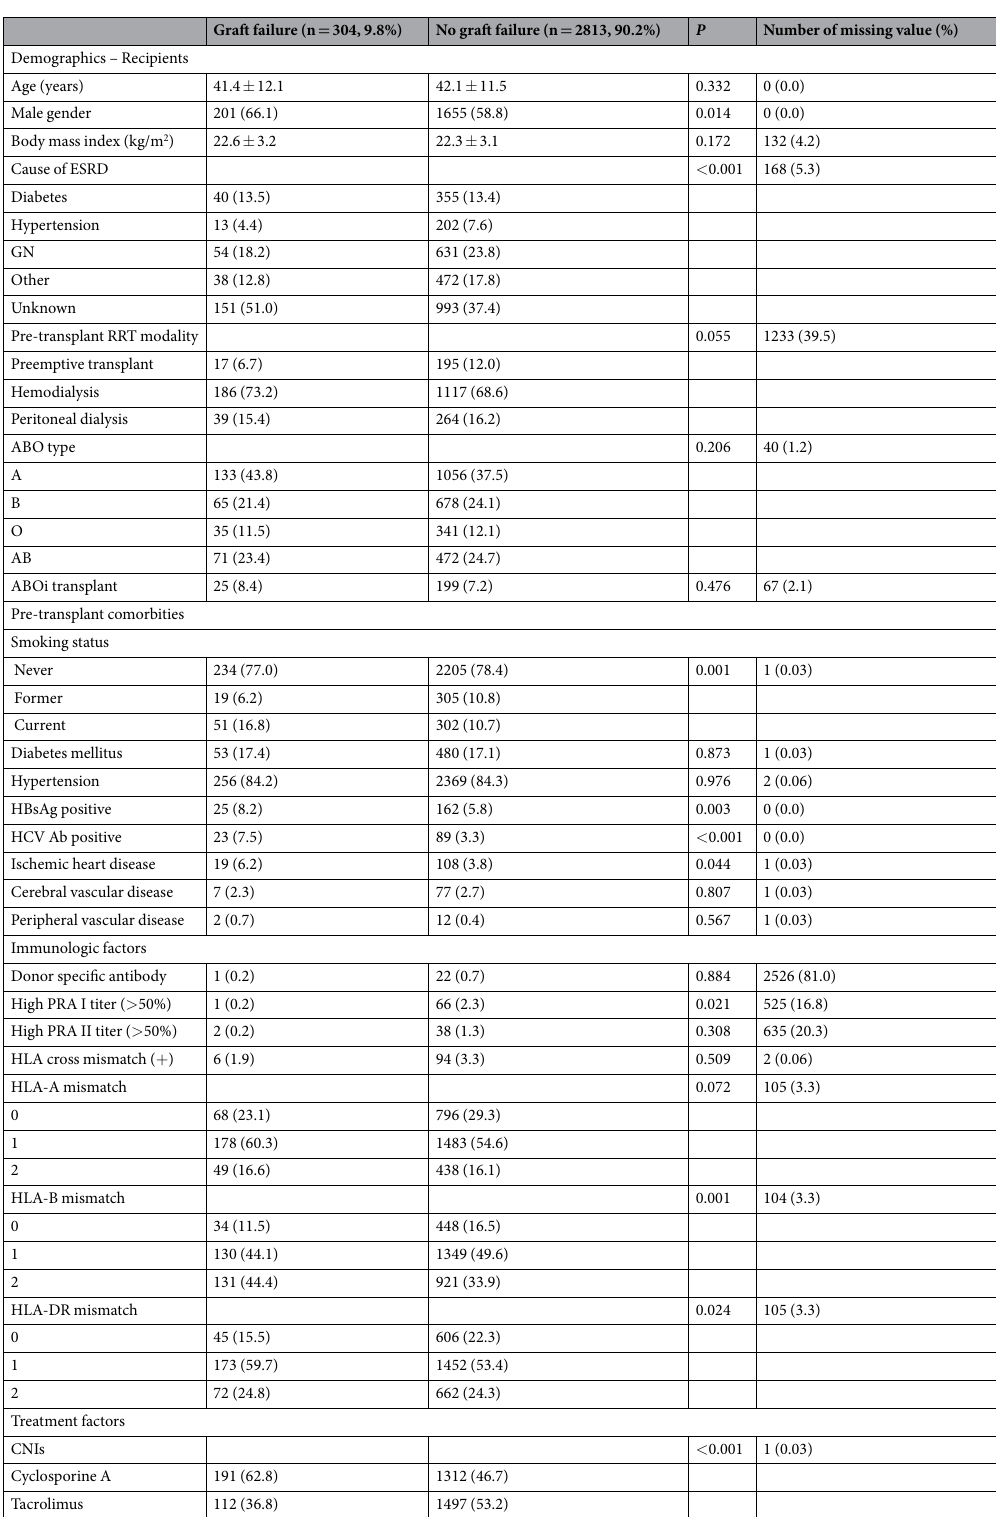
Table 1. Baseline demographic, immunologic characteristics and treatment- associated factors according to graft survival in kidney transplants recipients (KTRs). Abbreviations: ESRD, end-stage renal disease; GN, glomerular nephritis; RRT, renal replacement therapy; ABOi, ABO incompatible; HBsAg, Hepatitis B virus surface antigen; HCV Ab, hepatitis C virus antibody; CMV IgG, cytomegalovirus immunoglobulin G; PRA, panel reactive antibody; HLA, human leukocyte